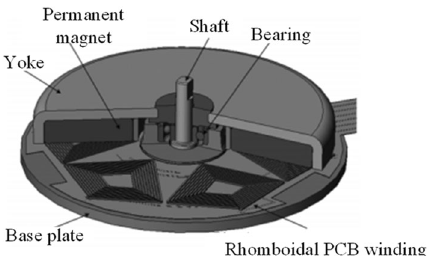
Figure 25 Structure of miniature AFPMSM with rhomboidal PCB coil